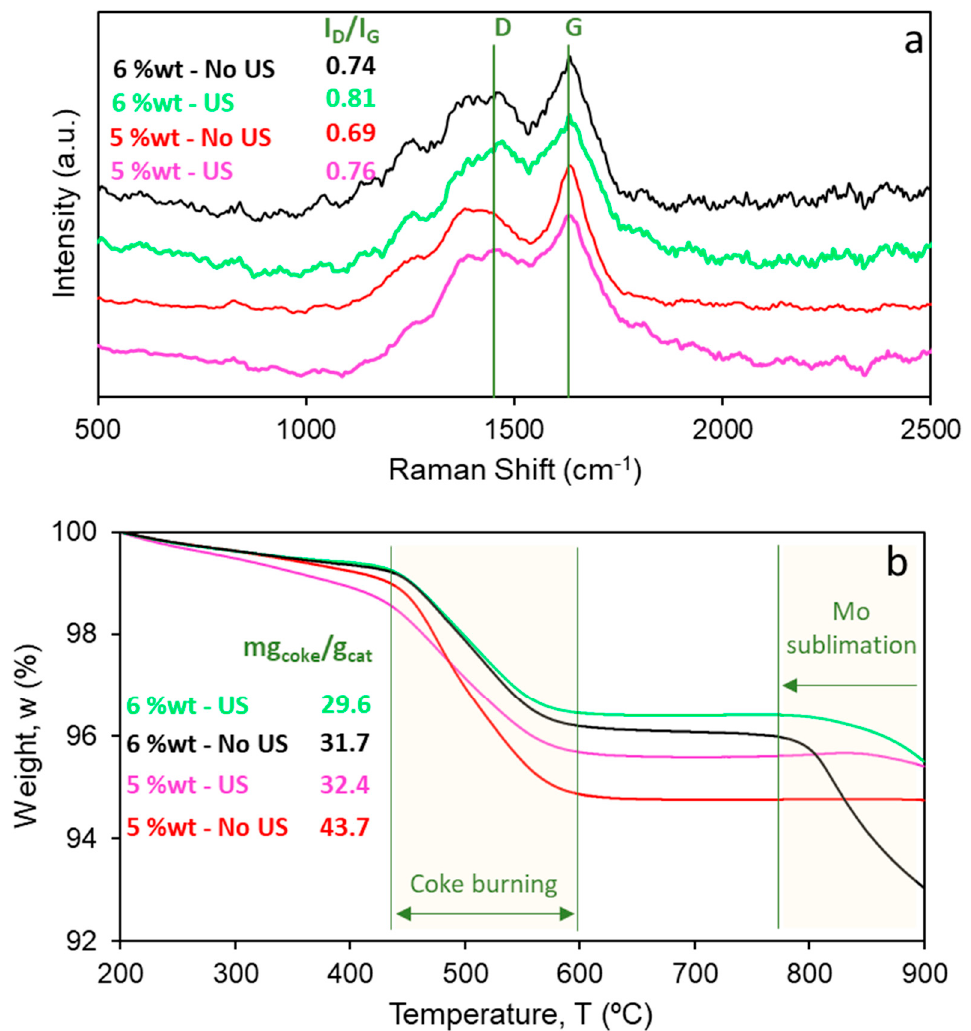
Figure 9. ( a ) Raman spectra of coked Mo/ZSM-5 samples after MDA showing the rate between the maximum intensity of the disordered and graphitic coke bands (I D /I G ); ( b ) thermogravimetric analysis of Mo/ZSM-5 coked samples showing the relative amount of coke deposits generated under MDA operation. Time on stream (TOS): 6 h. Operational conditions: 1500 mL/g cat h, CH 4 :N 2 = 80:20, T = 700 °C, P = 1 bar.